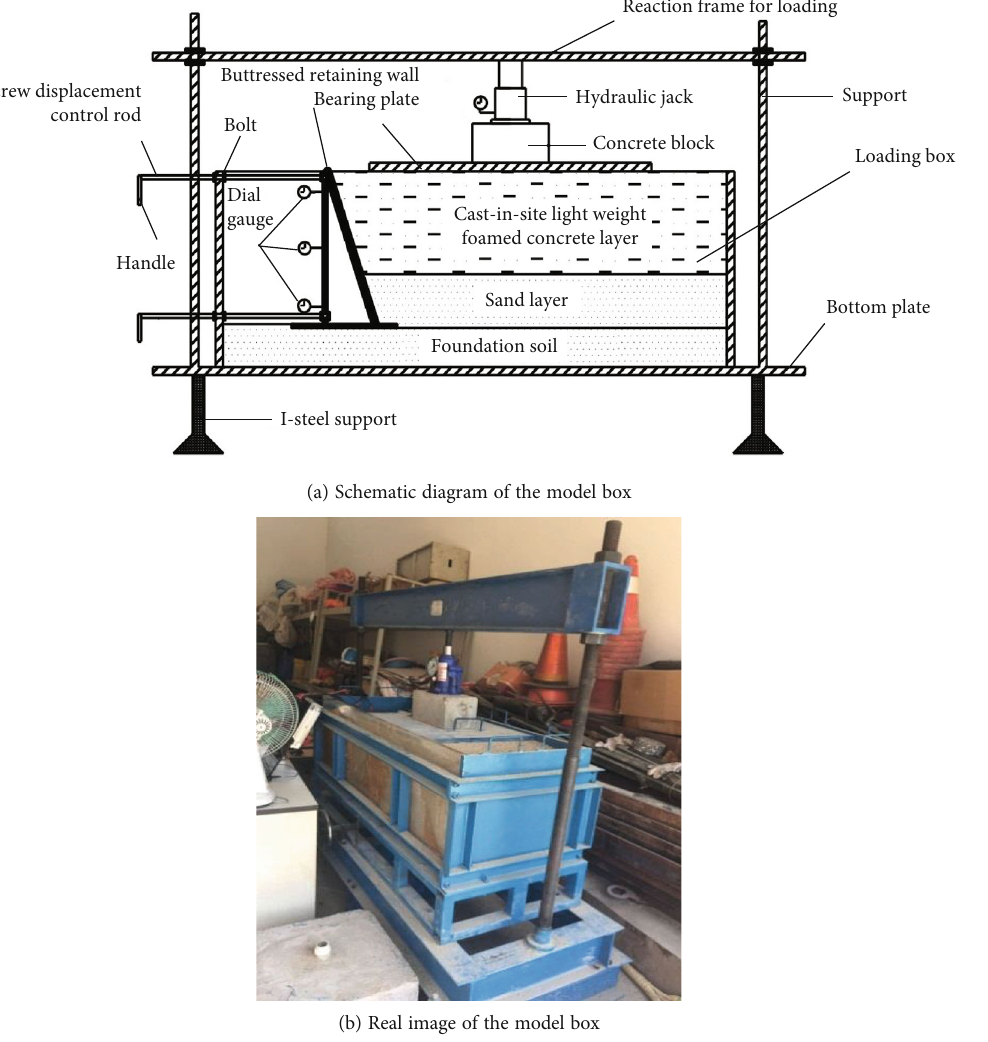
Figure 2: The test model